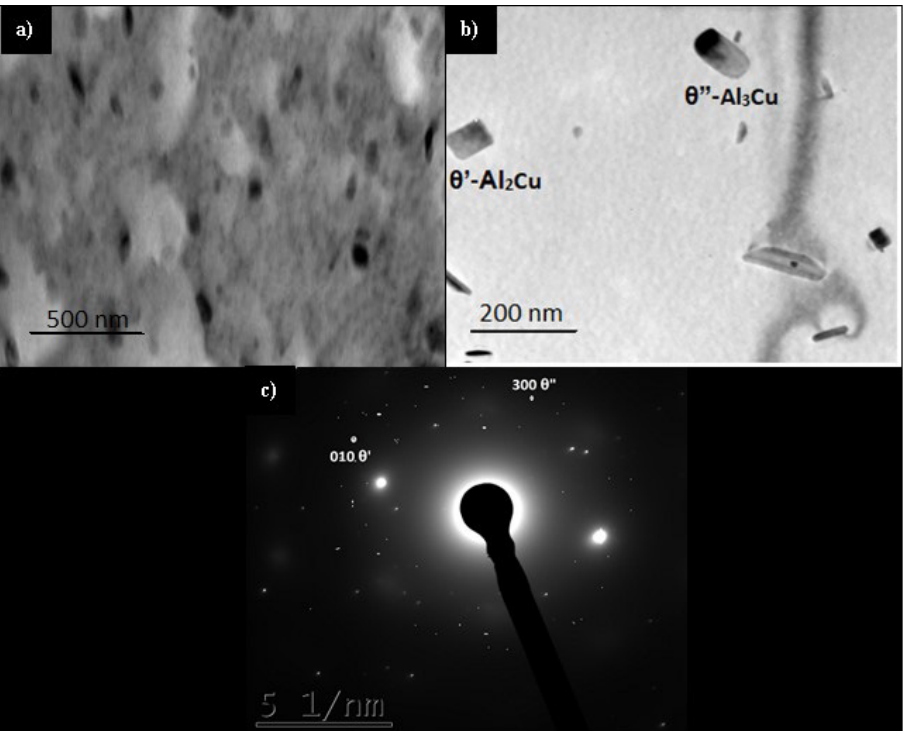
composite aged at 100°C shows presence of θ” phase - Al 2